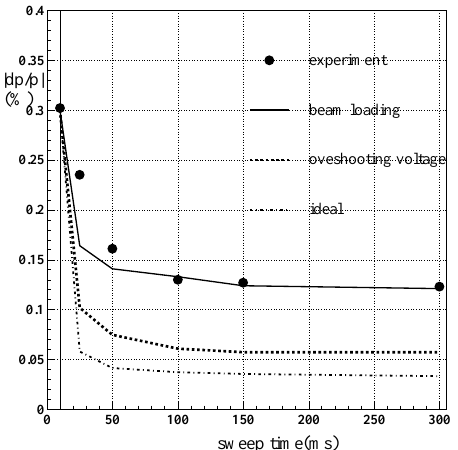
FIG. 15. Simulation results about adiabatic debunching. The horizontal and vertical coordinates are the sweep time and momentum spread, respectively. The initial bunch width and momentum spread were 24 ± and 6 0.003 , respectively. The beam intensity was 7.0 3 10 12 protons (cid:1) bunch. The longitudinal mismatch was minimized. The initial momentum spreads are shown on the solid line. The case without any potential distortion is presented as “ideal.” The results, including beam loading, agree with the experimental results.